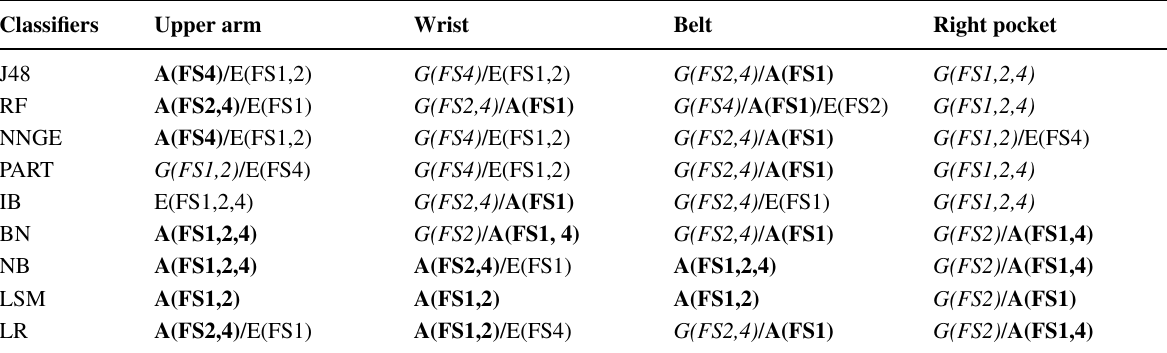
Table 6. Leading role: Accelerometer vs . gyroscope for the walking upstairs activity.